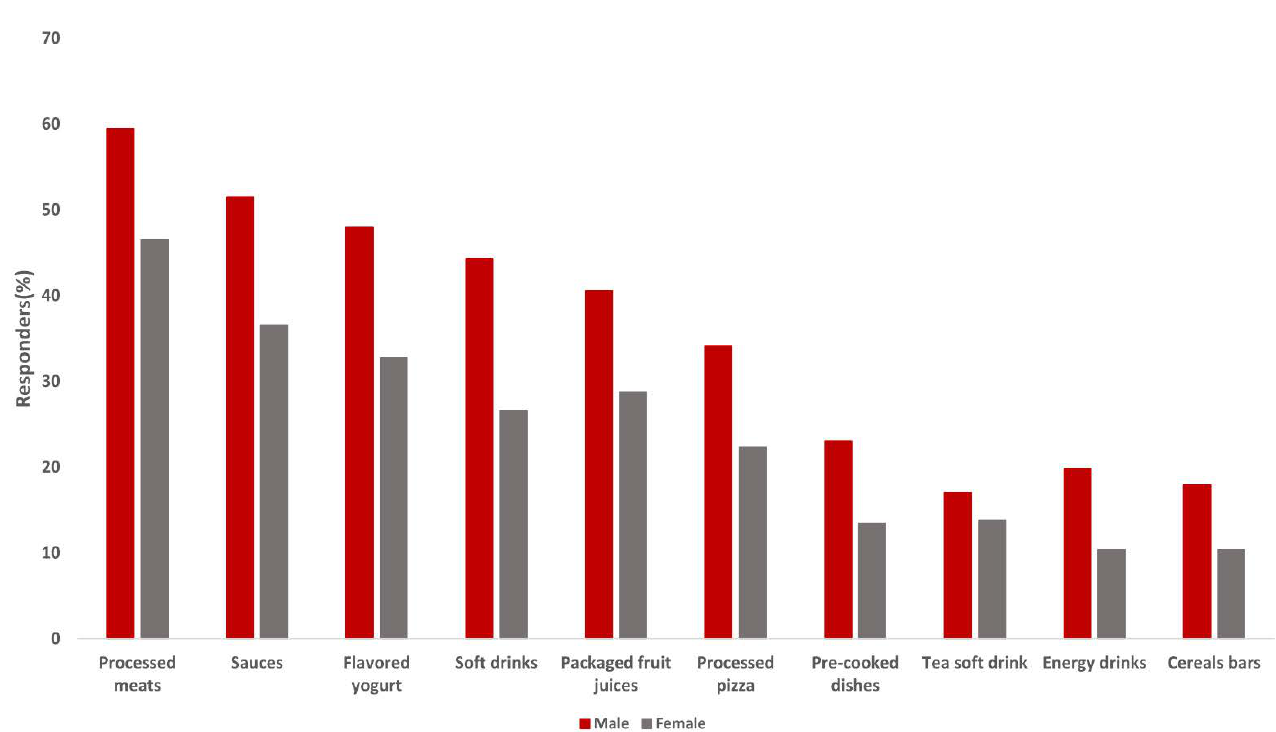
Figure 1. Graphical display of the percentage of male and female adolescents consuming those ultra-processed foods and drinks that statistically differ between these groups.